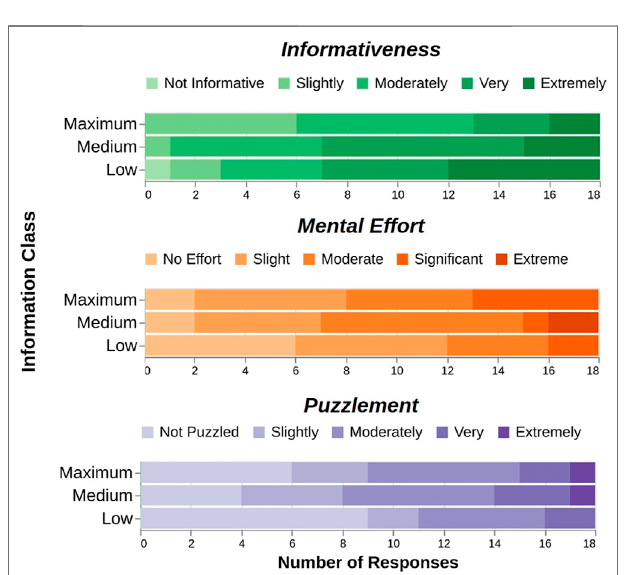
FIGURE 5 | The information class of demonstrations only signi fi cantly in fl uences their perceived informativeness, ironically decreasing from low to maximum information class. This suggests that a demonstration ’ s intrinsic information content (as measured by its BEC area) does not always correlate with the information transferred to human learners. No signi fi cant effectswerefoundbetweeninformationclassandmentaleffortorpuzzlement.